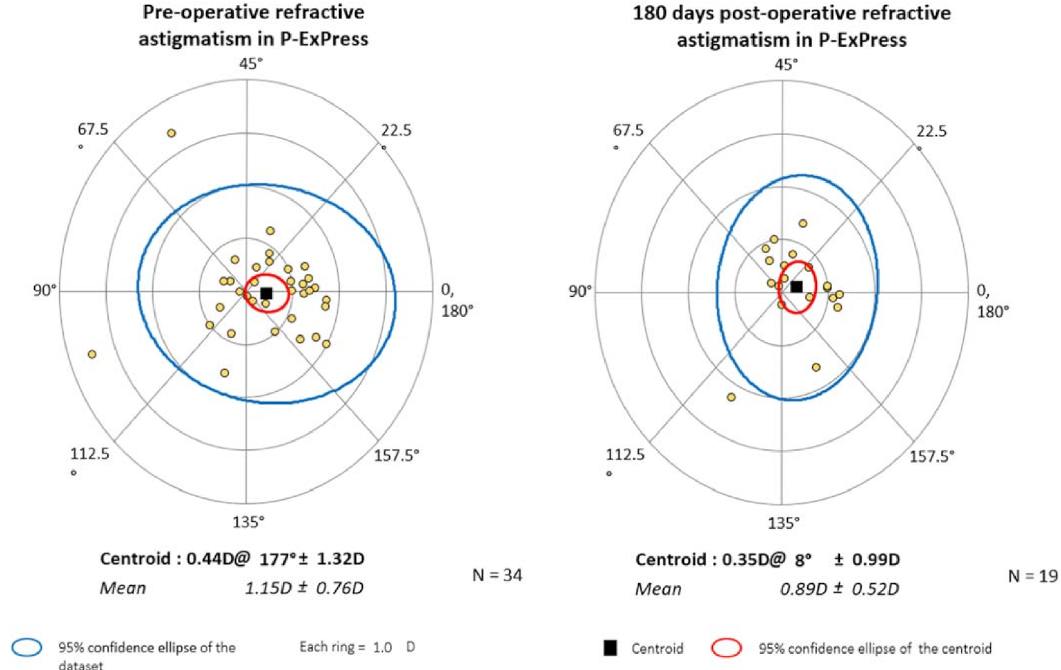
Figure 4. The mean values of astigmatism, with the axes, presented in centroid form on double angle plots for the P-Ex- PRESS group (The black square indicates the centroid. The red circle indicates the 95% confidence ellipse of the centroid. The blue circle indicates the 95% confidence ellipse of the dataset. Yellow dots indicate individual values of astigmatism. Each ring indicates 1.0 D. In P-Ex-PRESS astigmatism trend it is against the rule before and after